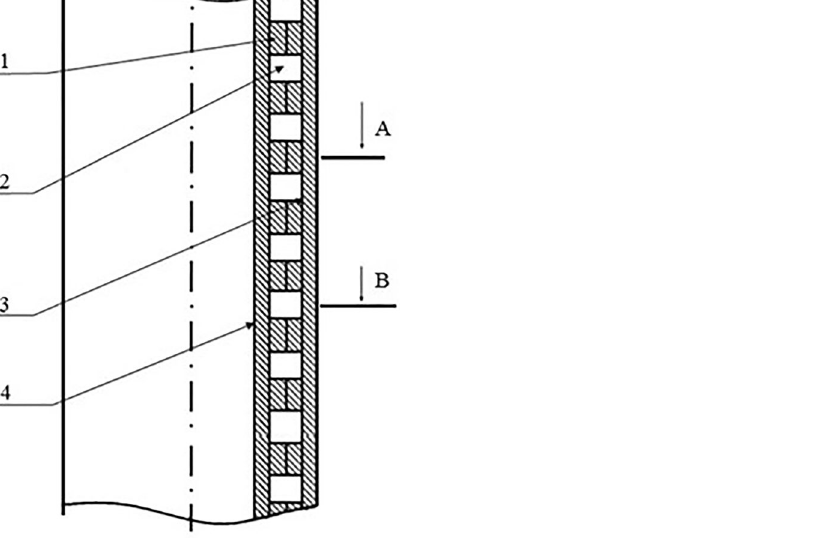
Figure 5. Scheme of tubing with impulse sectional